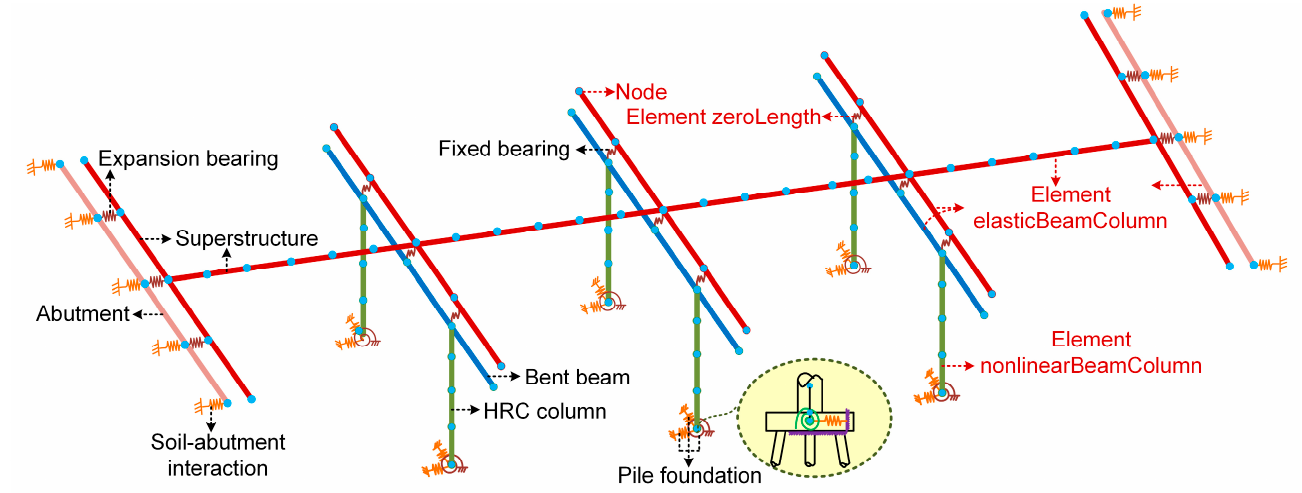
Figure 14. Finite element model of the analyzed HRC bridge.